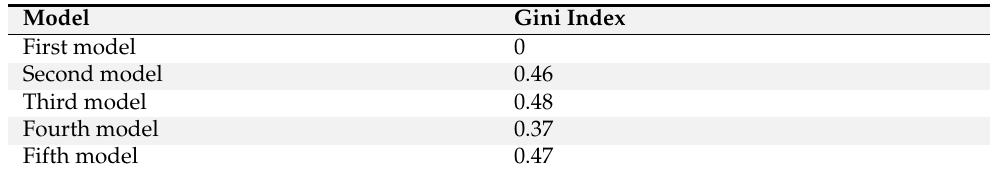
Table 5. Gini index of the